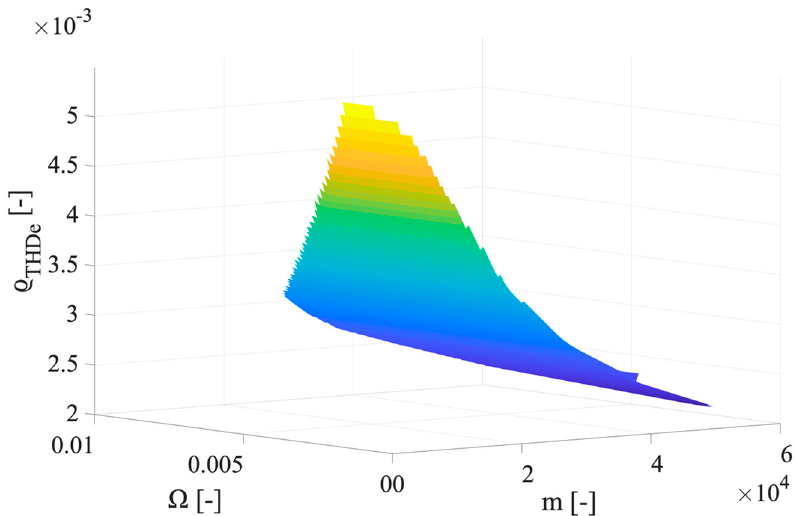
Figure 4. Graph of 𝜚 (cid:3021)(cid:3009)(cid:3005)_(cid:3032) values vs. 𝑚 and 𝛺 , for the accuracy class 0.1. Figure 4. Graph of (cid:37) THD _ e values vs. m and